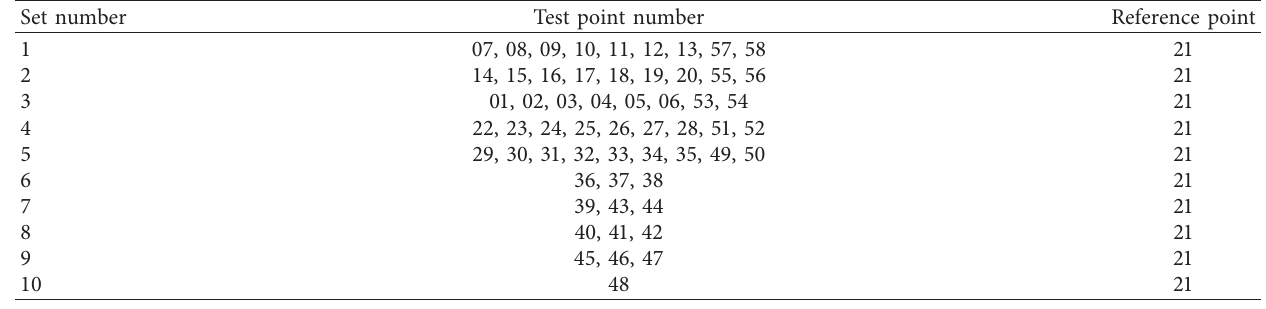
Table 1: Setup of measurement points.